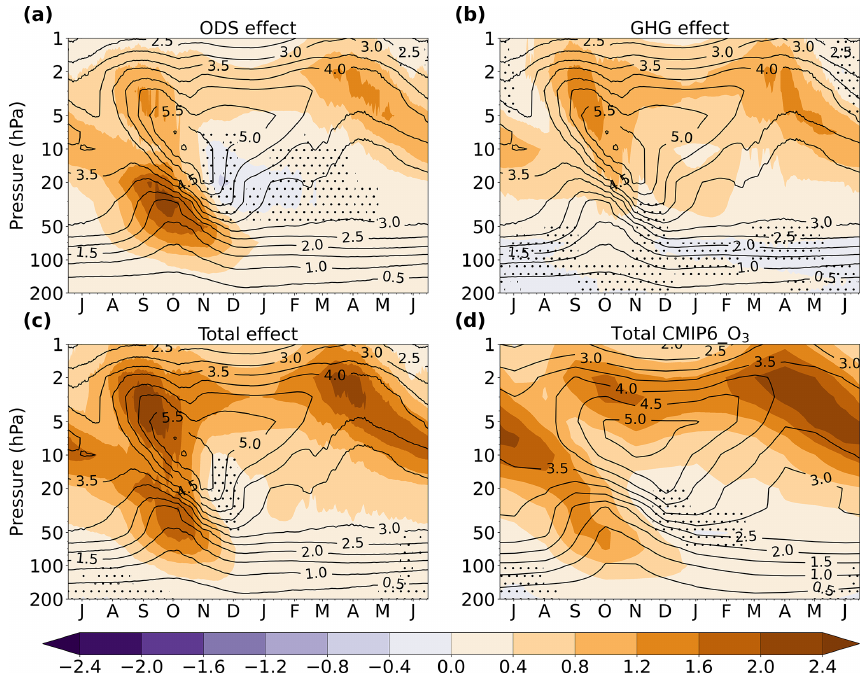
Figure 1. Changes in the polar cap (70–90 ◦ S) ozone (ppmv) for each day of the year and pressure level (color shading): effect of ODSs (a) , effect of GHGs (b) , total effect when ozone is interactive (c) , and total effect prescribed in CMIP6_O 3 (d) . The contours depict the current- day (2011–2030) climatology from INTERACT_O 3 in (a) – (c) and the climatology prescribed in CMIP6_O 3 in (d) . The stippling masks regions where the changes are not significant at the 95% confidence interval based on a two-tailed t